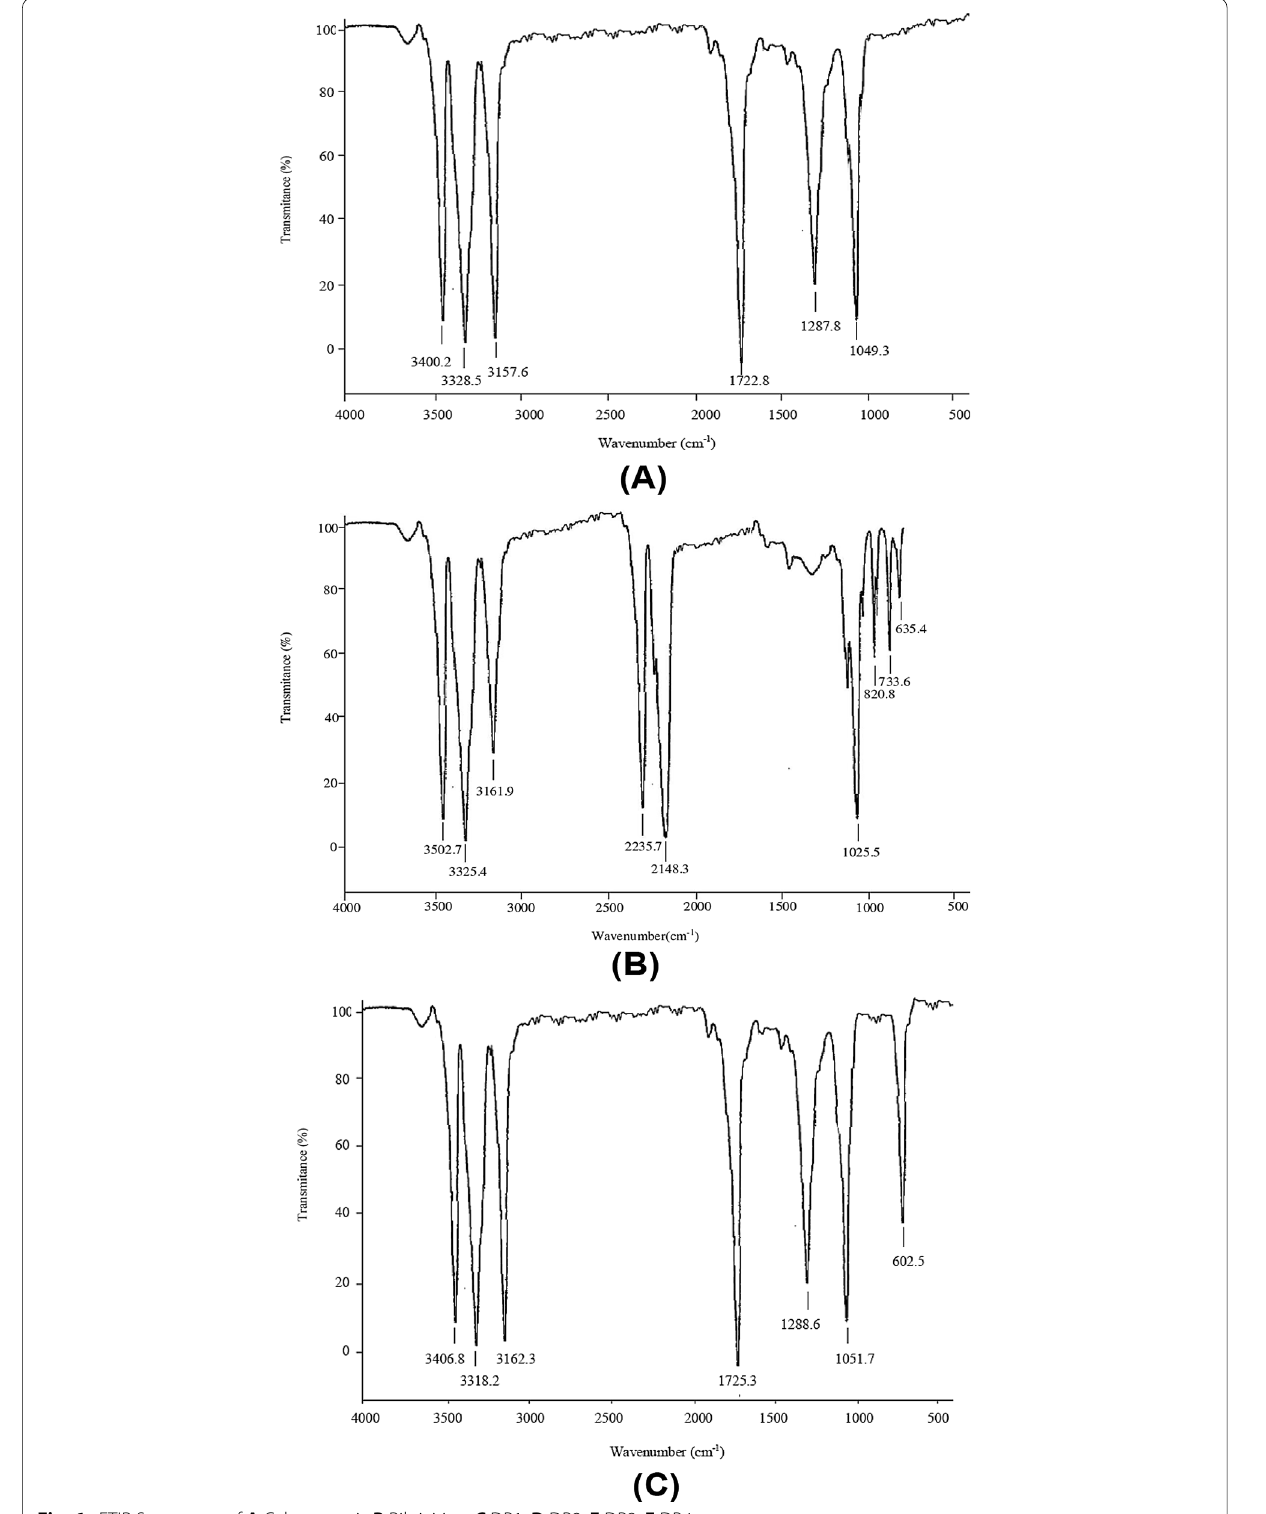
Fig. 6 FTIR Spectrums of A Cabotegravir, B Rilpivirine, C DP1, D DP2, E DP3, F